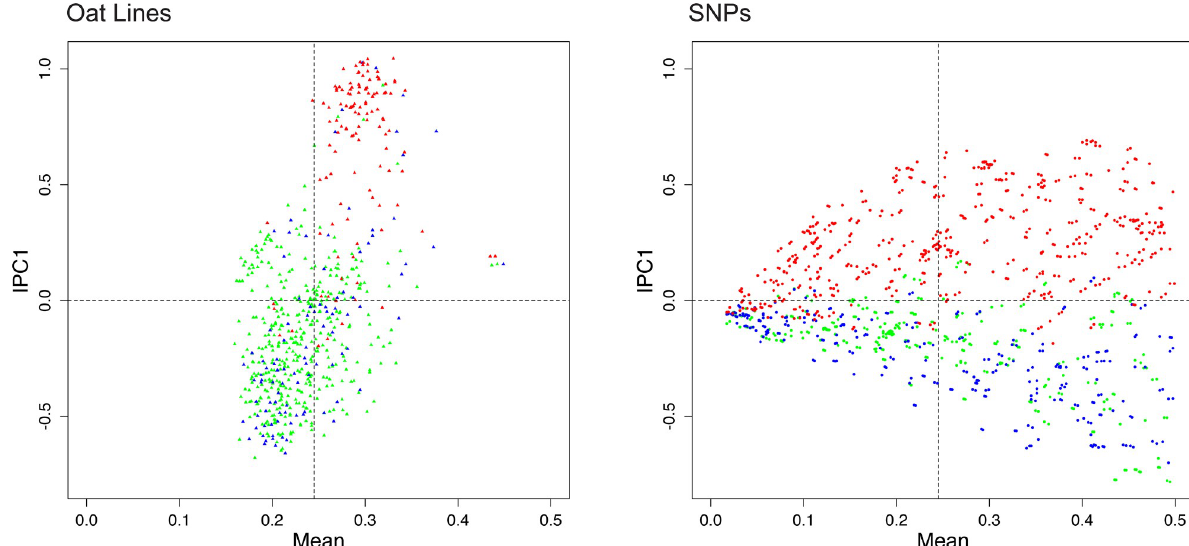
Fig 7. The AMMI1 biplot for the oat data, using SNP coding rare = 1. To reduce clutter the biplot uses two panels, with oat lines on the left and SNPs on the right. The color scheme is the same as in Fig 1, namely spring oats show in green, world diversity oats in blue, and winter oats in red, with corresponding colors for the SNPs. The abscissa shows main effects and the ordinate shows IPC1.